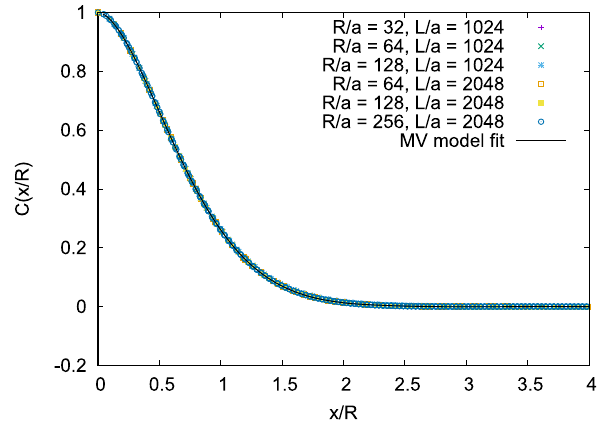
Fig. 7 VolumeandlatticespacingdependenceoftheMVdipoleampli- tude. Results from different volumes and lattice spacings fall on top of each other providing evidence of negligible finite volume and finite lattice spacing effects. κ was set to 1.0 in this